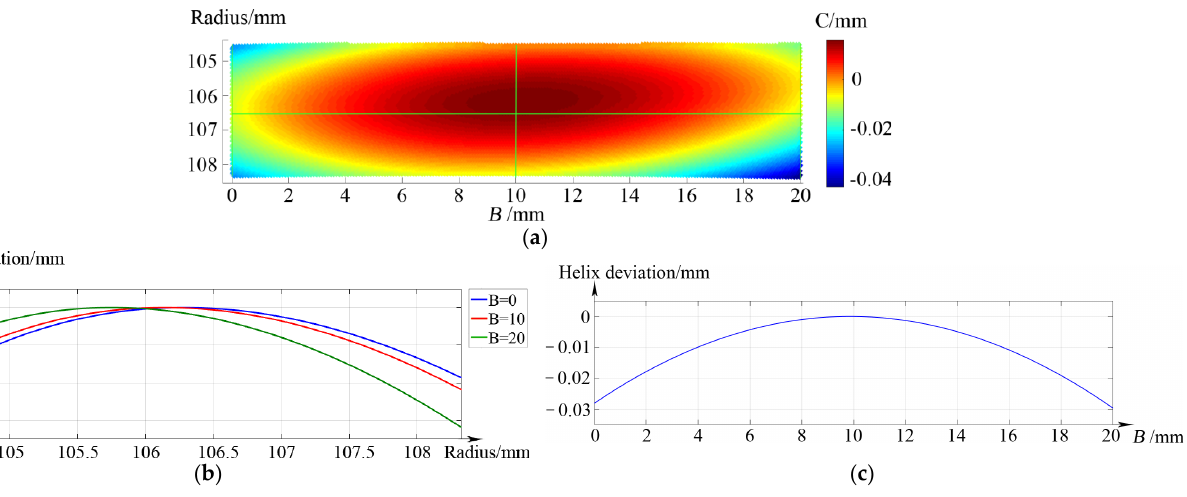
Figure 4. Calculated deviations of the gear tooth flank enveloped via general skiving method. ( a ) deviation contour plot, ( b ) profile deviation, ( c ) helix deviation. The deviation contour plot of the tooth flank enveloped via the alterable shaft angle skiving method is shown in Figure 5b. The shapes and amplitudes of the tooth profile curves are quite similar, which means the tooth flank twist is